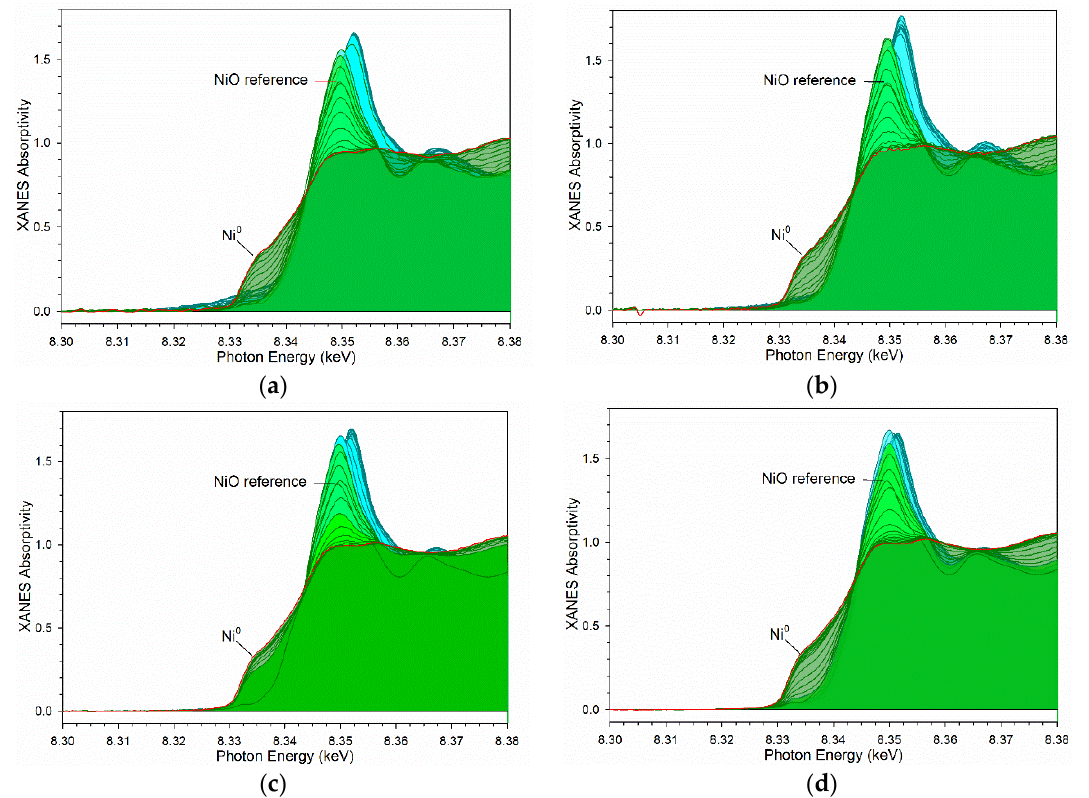
Figure 12. H 2 -TPR-XANES spectra at the Ni K-edges of ( a ) 25%M (M = 5%Ni-95%Co) / Al 2 O 3 , ( b ) 25%M (M = 10%Ni-90%Co) / Al 2 O 3 , ( c ) 25%M (M = 25%Ni-75%Co) / Al 2 O 3 , and ( d ) 25%M (M = 50%Ni-50%Co) / Al 2 O 3 . (Cyan) is Ni 2 + (e.g., NiO) associated with cobalt oxides during reduction of Co 3 O 4 to CoO. (Green) is reduction of Ni 2 + to Ni 0 when NiO reduction is associated with CoO reduction to Co 0 .